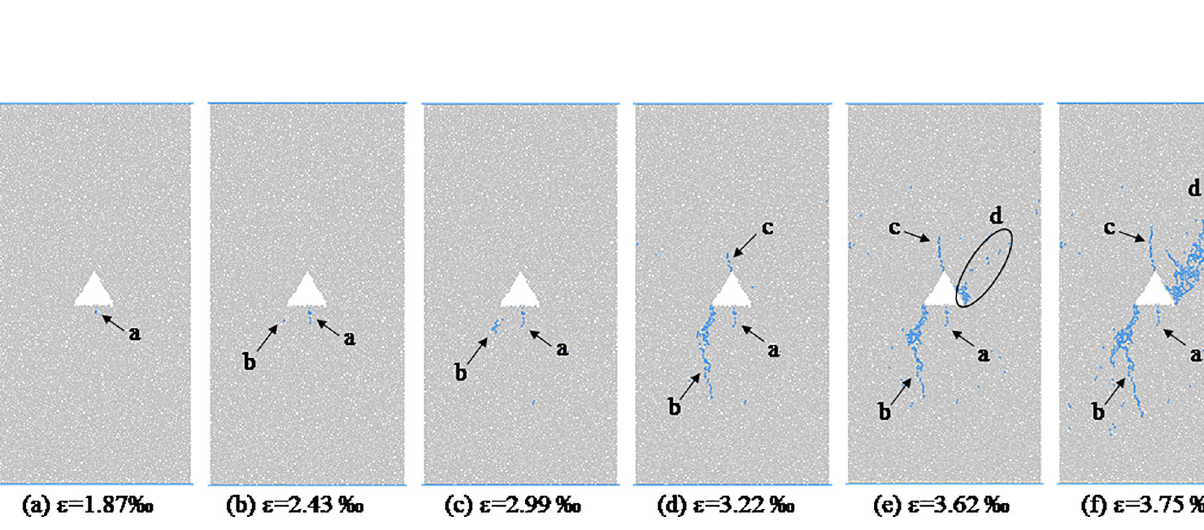
PLOS ONE | https://doi.org/10.1371/journal.pone.0265753 March 22,